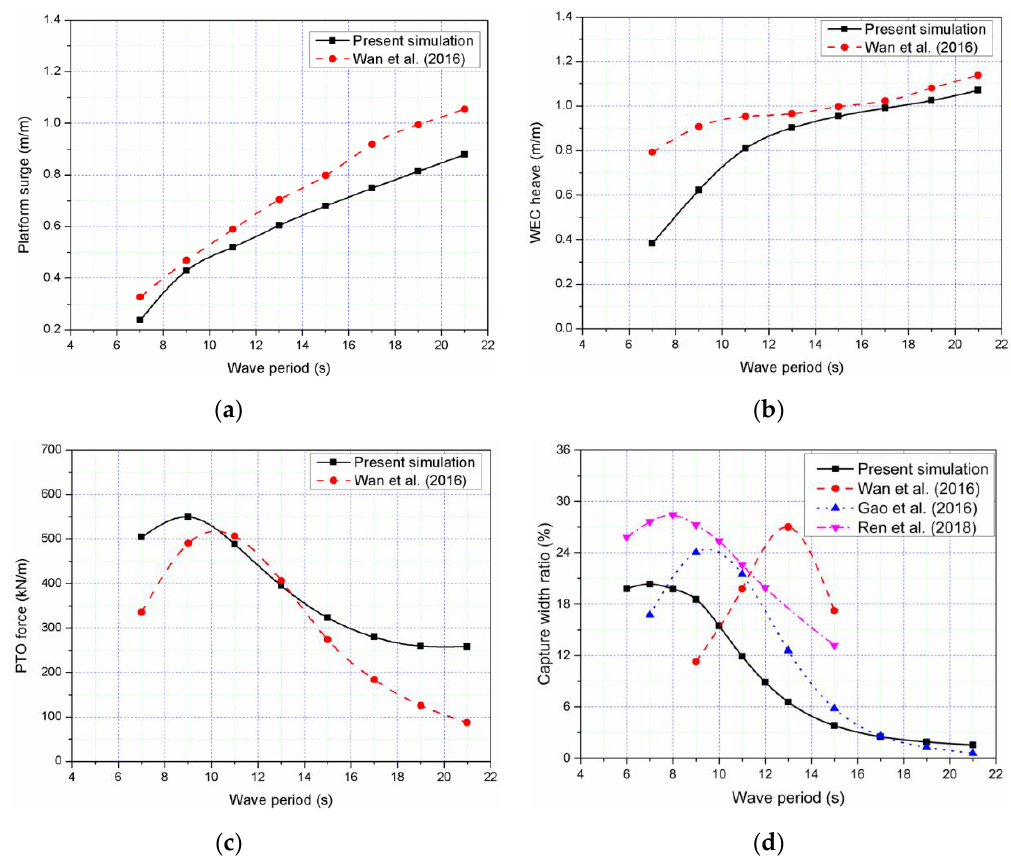
Figure 11. Responses of the combined structure under different wave periods with H = 2 m: ( a ) platform surge; ( b ) WEC heave; ( c ) power take-off (PTO) force; ( d ) capture with ratio.